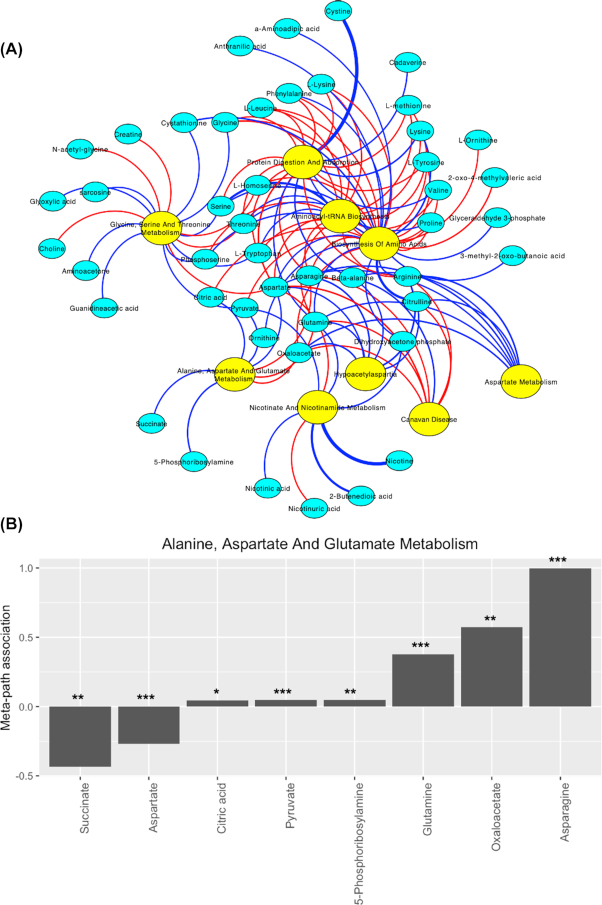
Metabolite-pathway relationship analysis. (A) Bipartite plot with top 10 pathways and corresponding metabolites. Cyan and yellow nodes indicate metabolites and pathways, respectively. Red and blue edges are negative (−) and positive (+) associations, respectively. Thicker edges indicate higher levels of association. (B) Bar plots of the relationship between the Alanine, Aspartate And Glutamate Metabolism pathway and its corresponding metabolites. *P < 0.05; **P < 0.01; ***P < 0.001.